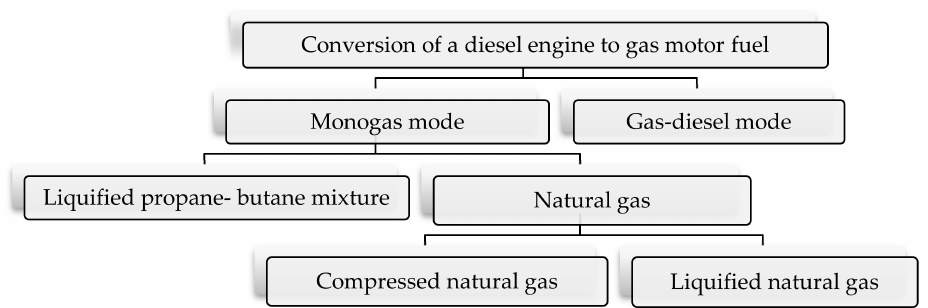
Figure 1. Directions of conversion of diesel engines to